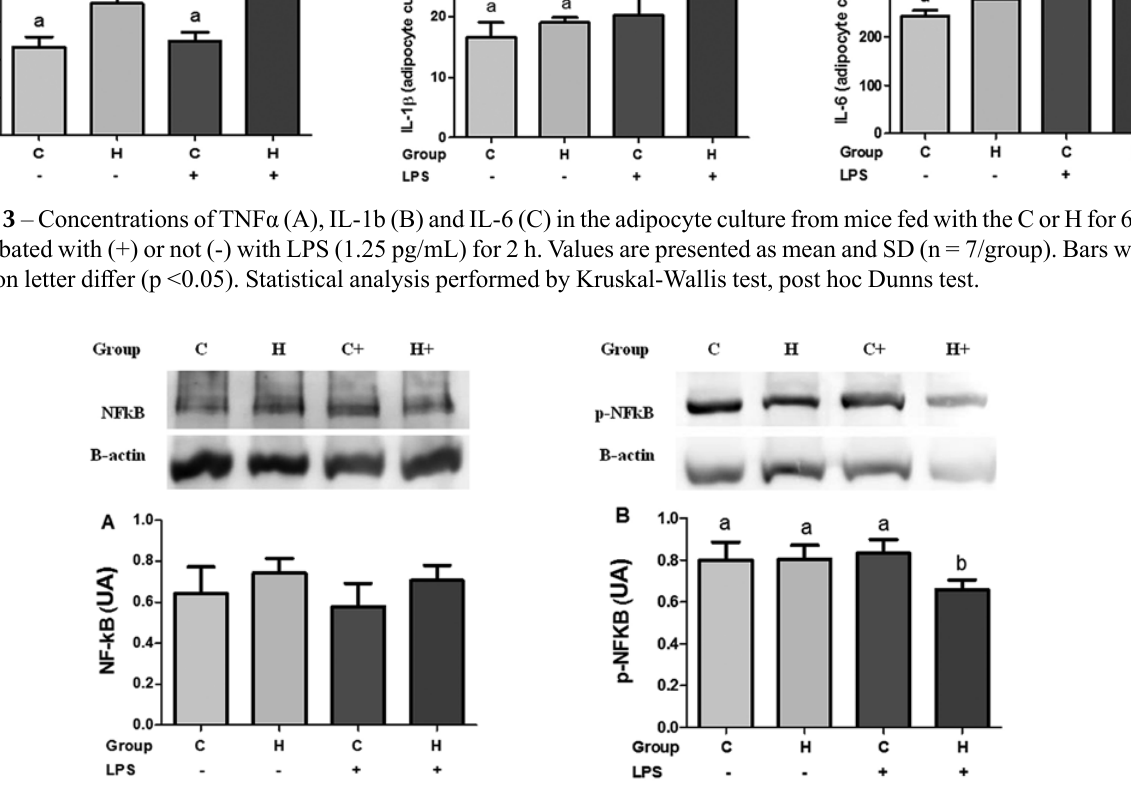
FIGURE 4 – Total (A) and phosphorylated (B) NFkB expression in culture of peritoneal macrophages from mice fed the C or H for 6 week and incubated (+) or not (-) with LPS (1.25 pg/mL) for 2 h. (n = 6/group).